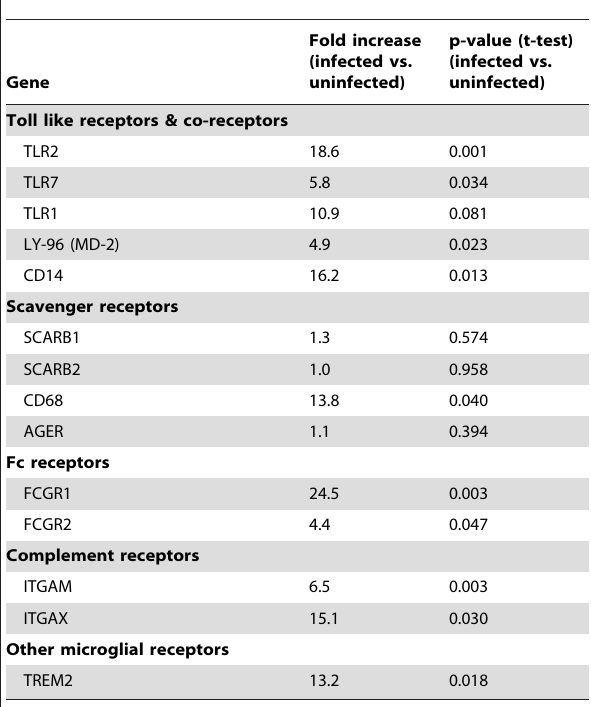
Table 2. Expression levels of microglial cell surface receptors in hippocampal tissue of RML infected, symptomatic mice as determined by microarray analysis.